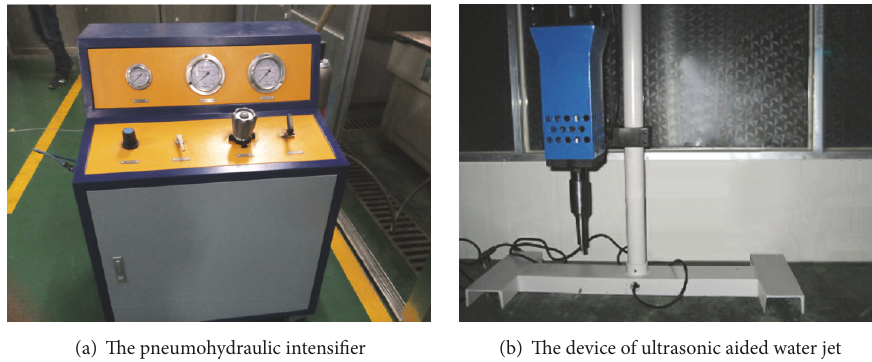
Figure 2: The device of ultrasonic vibration aided abrasive water